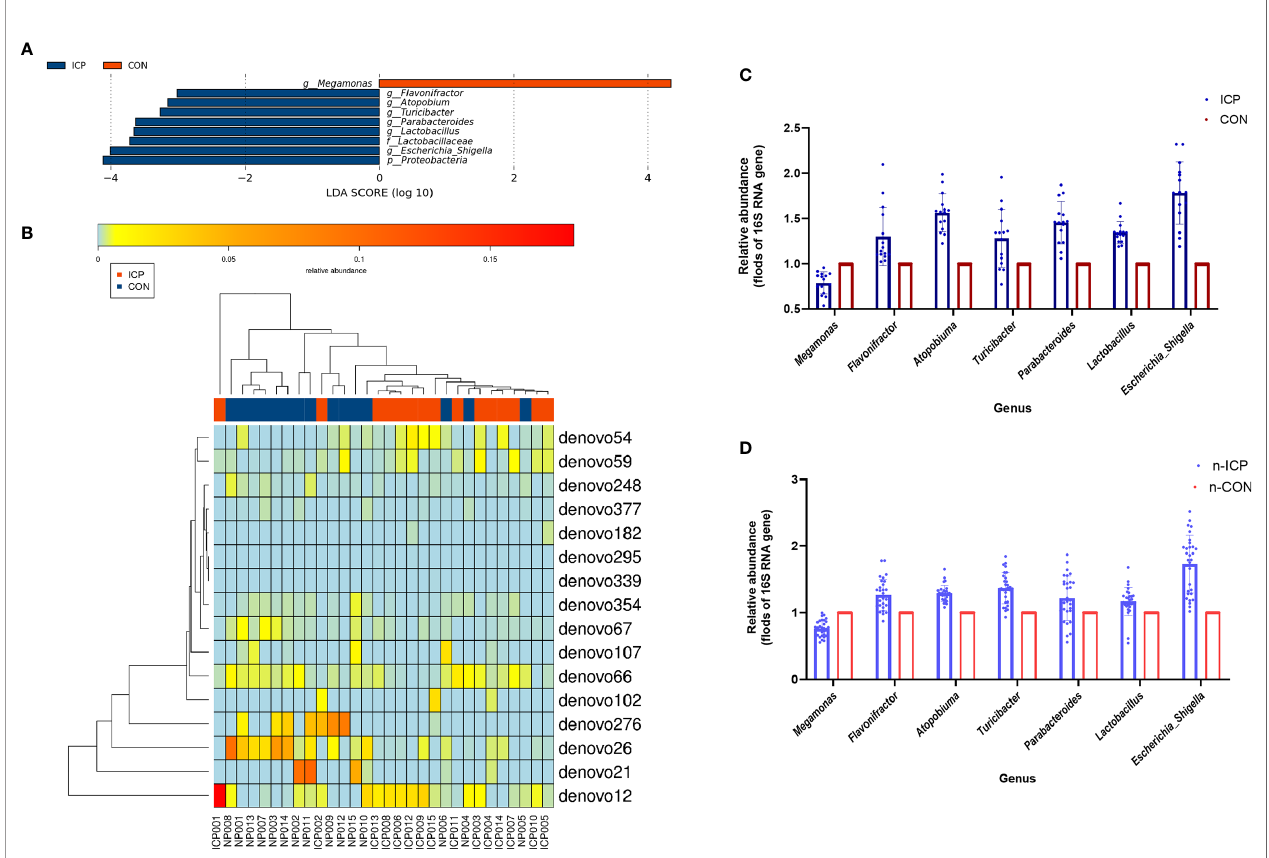
FIGURE 2 | Comparison of gut microbiota between the ICP patients and healthy individuals. (A) Taxonomic differences in the microbial 16S rRNA gene through LEfSe analysis. (B) The Heatmap of differential OTUs between the ICP patients and healthy individuals. The transverse clustering shows that the abundance of the phylotypes is similar in each sample, and the longitudinal clustering shows the similarity of the expression of all phylotypes among different samples, the closer the distance is, the shorter the branch length is. Blue represents the ICP group, and red represents the healthy group. (C) The relative abundance of the seven genera between the ICP and healthy controls were con fi rmed using real-time PCR. (D) The relative abundances of the same seven genera were validated in the other two independent groups of 30 ICP patients and 30 healthy individuals by real-time PCR. Blue scatter plot with error bars represents the ICP patients, and red scatter plot with error bars represents the healthy controls. Light blue and light red ones represent the new 30 ICP patients and 30 healthy controls,